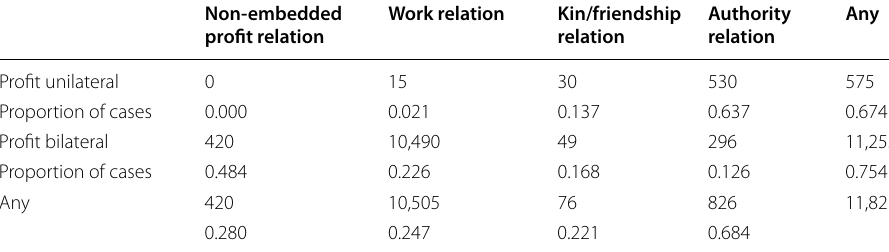
Proportions of cases indicate proportions with any of the dyad types